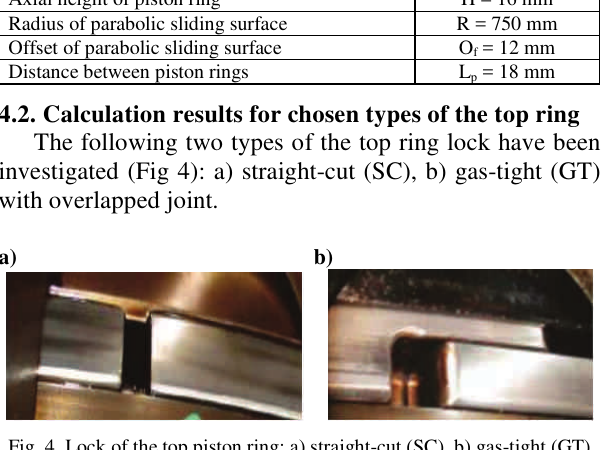
Fig. 4. Lock of the top piston ring: a) straight-cut (SC), b) gas-tight (GT) with overlapped joint (Copyright Winterthur Gas & Diesel Ltd.)